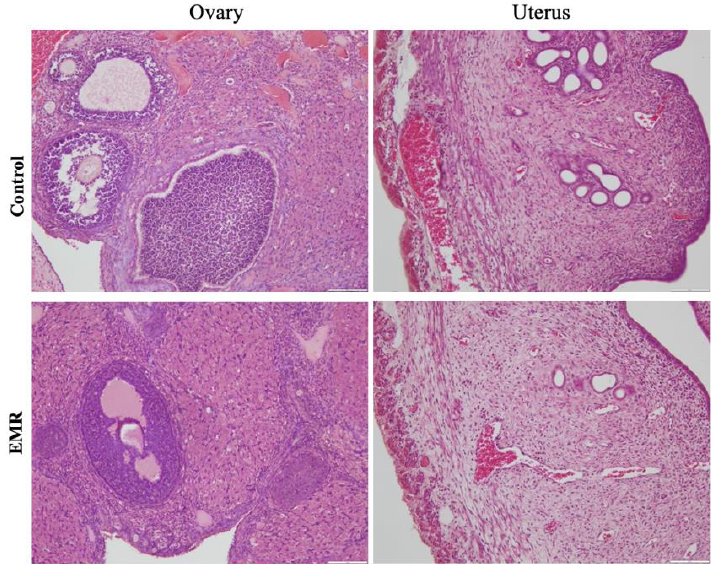
Figure 8. The effect of 150 kHz IF EMR on the histopathology of the ovary and uterus and pancreas of rats in the control and EMR groups after 2 months of whole-body exposure. The ovary showed typical ovarian morphology, including stromal cells and regular follicle formation. The uterine endometrium was normal, and myometrial smooth muscle fibres, uterine glands, and blood vessels were all regular. (H&E × 200).